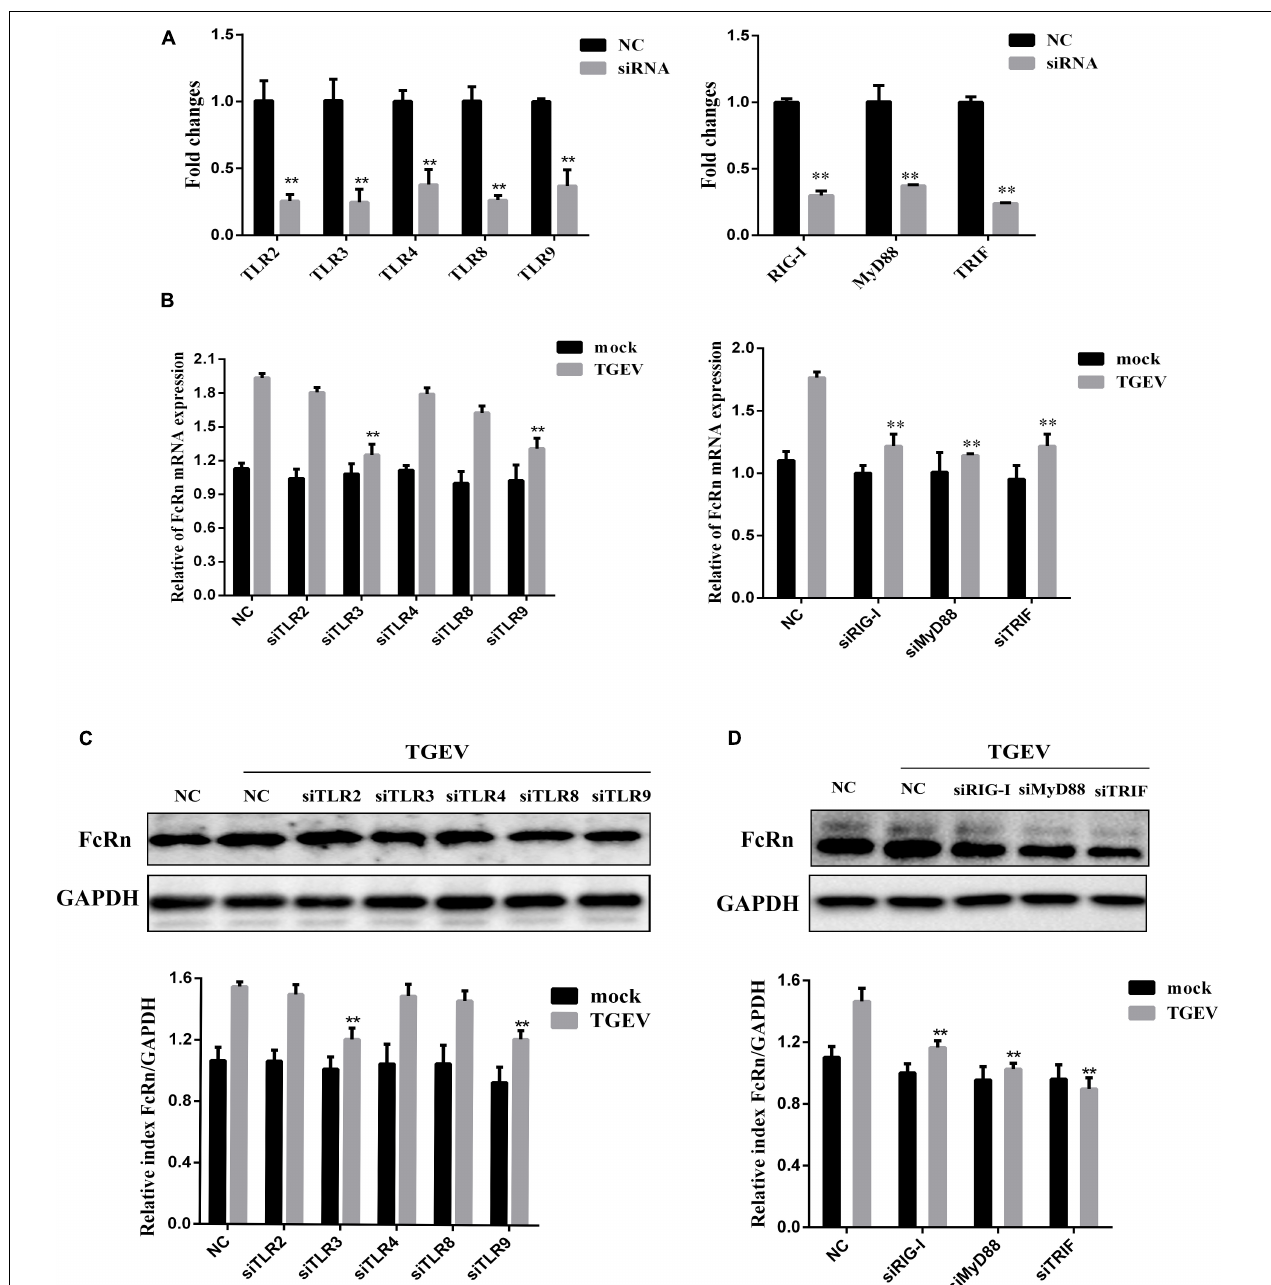
FIGURE 2 | Involvement of TLR signaling cascades in FcRn activation by TGEV. (A) IPEC-J2 cells were transfected with 50 nM specific siRNAs targeting TLR2/3/4/8/9, TRIF, MyD88, RIG-I or NC siRNA, respectively for 24 h, then cells were collected for analysis of mRNA levels using RT-qPCR assays. (B) IPEC-J2 cells were transfected with the siRNAs TLR2/3/4/8/9, TRIF, MyD88, RIG-I or NC siRNA, respectively for 24 h, then with/without TGEV infection (MOI = 1). At 24 hpi, total RNA was extracted and FcRn or GAPDH mRNA expression was analyzed by RT-qPCR. (C,D) IPEC-J2 cells were transfected with the siRNAs TLR2/3/4/8/9, TRIF, MyD88, RIG-I or NC siRNA, respectively for 24 h, then with/without TGEV infection (MOI 1). IPEC-J2 cells were harvested at 36 hpi and measured by Western blot. The right panel represents the quantification of the bands by densitometry, corrected by the amount of GAPDH. ∗∗ p <